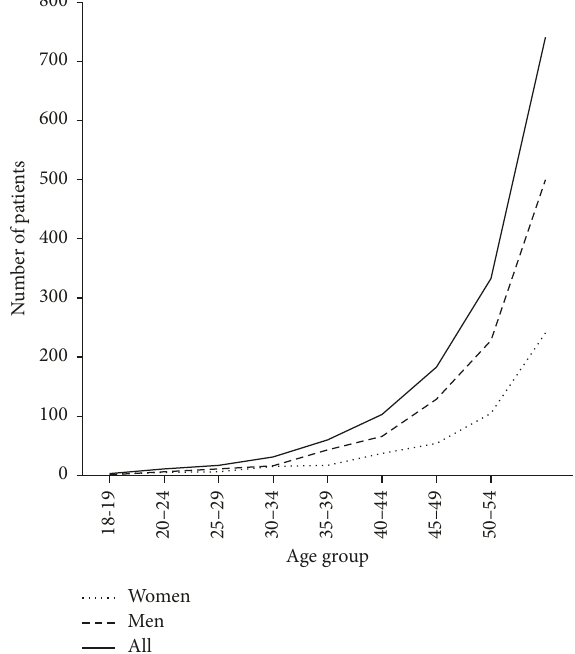
Figure 1: Patients with first-ever stroke according to age groups (number of men, women, and